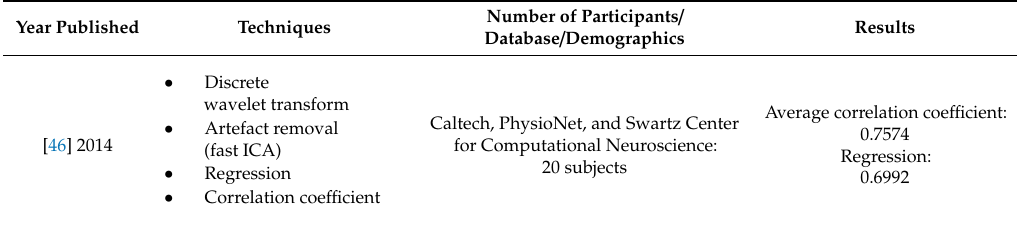
Table 3. A summary of studies using computer-aided brain diagnostic system (CABDS) for the prediction / diagnosis of ASD using electroencephalogram (EEG)